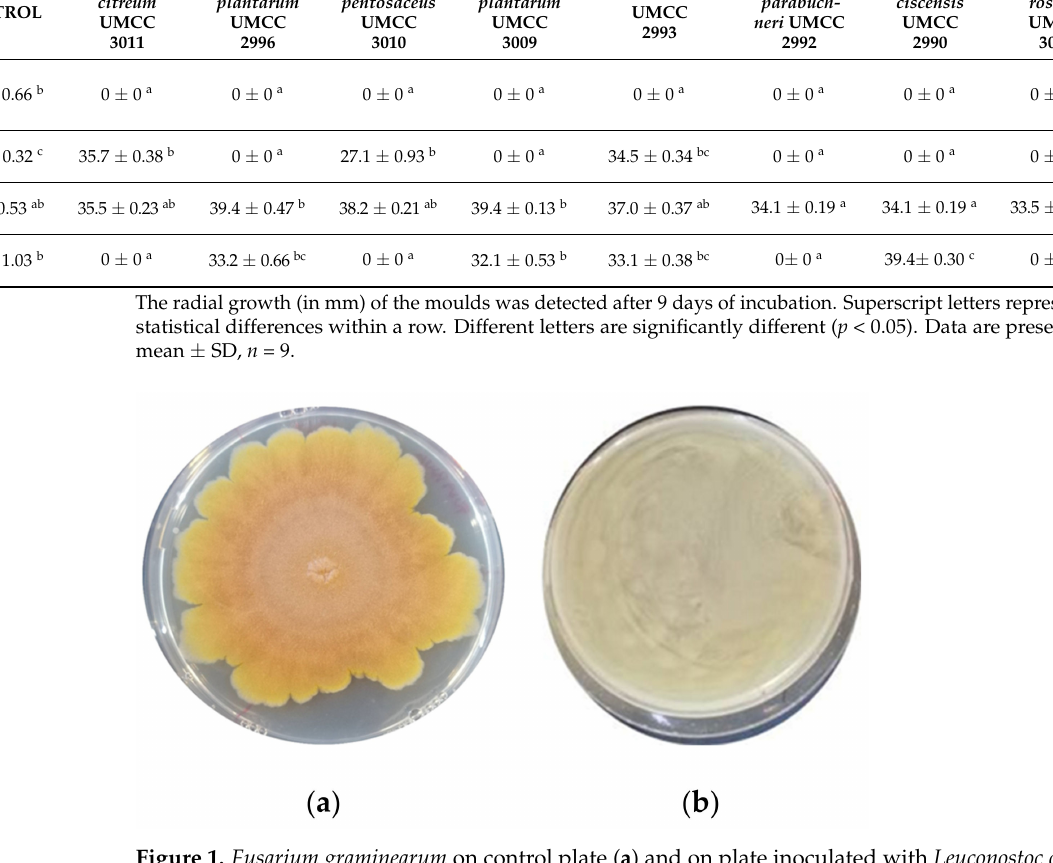
Figure 1. Fusarium graminearum on control plate ( a ) and on plate inoculated with Leuconostoc citreum UMCC 3011 ( b